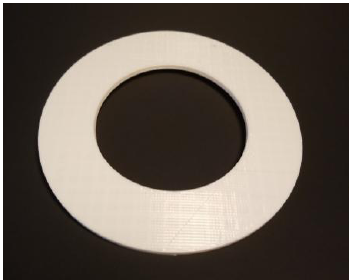
Figure 2. Example of flexible 3-D printed automotive related part, 2″ gasket—shown enlarged for clarity.